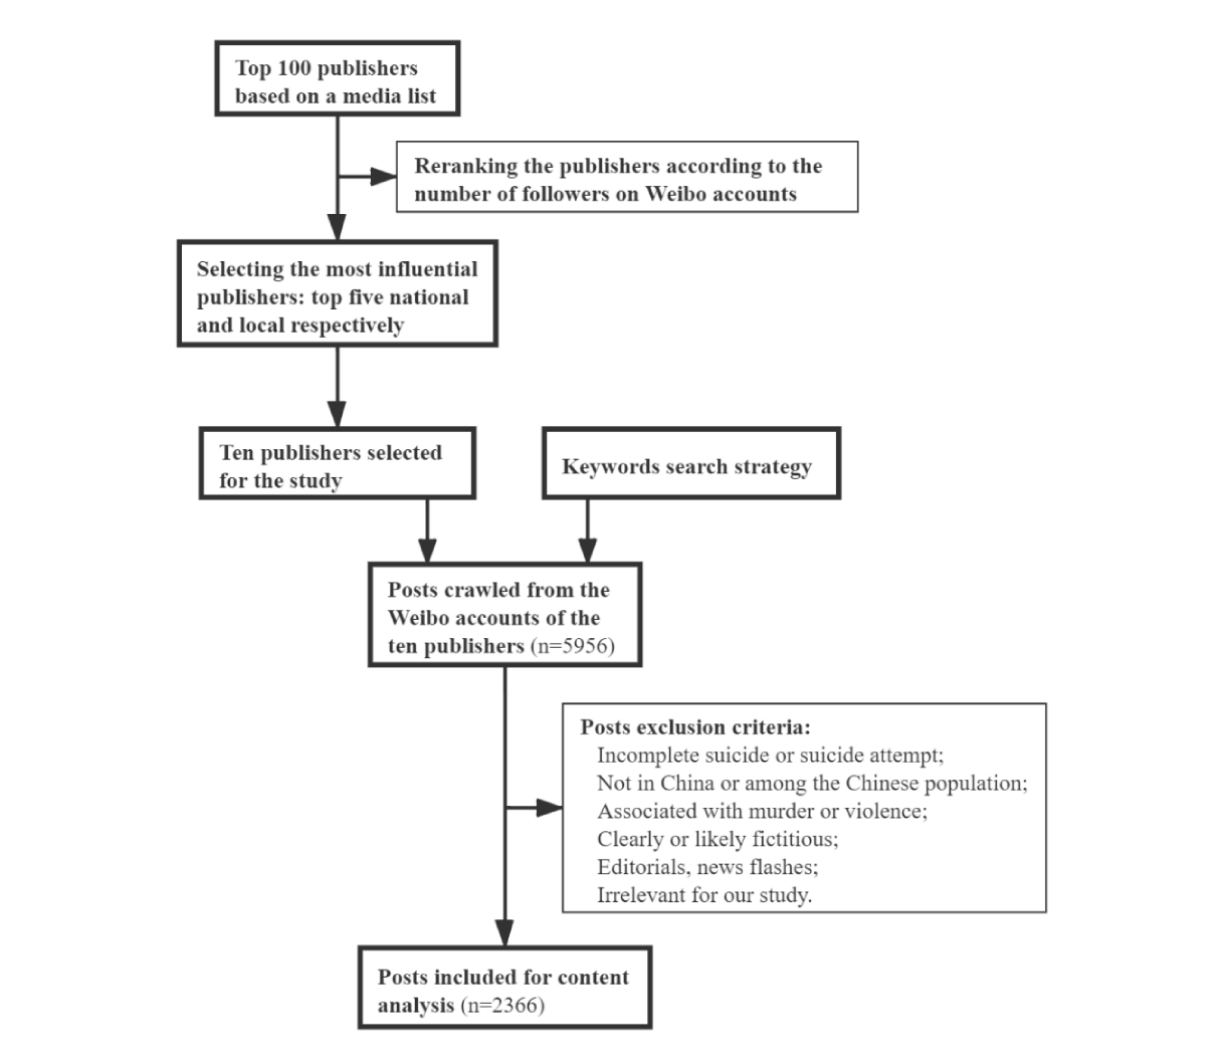
Figure 1. Flowchart of mainstream publishers selected and data